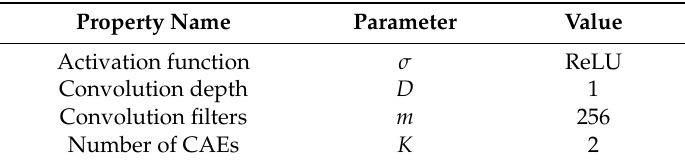
Table 2. Parameters of the training modulation classifier.